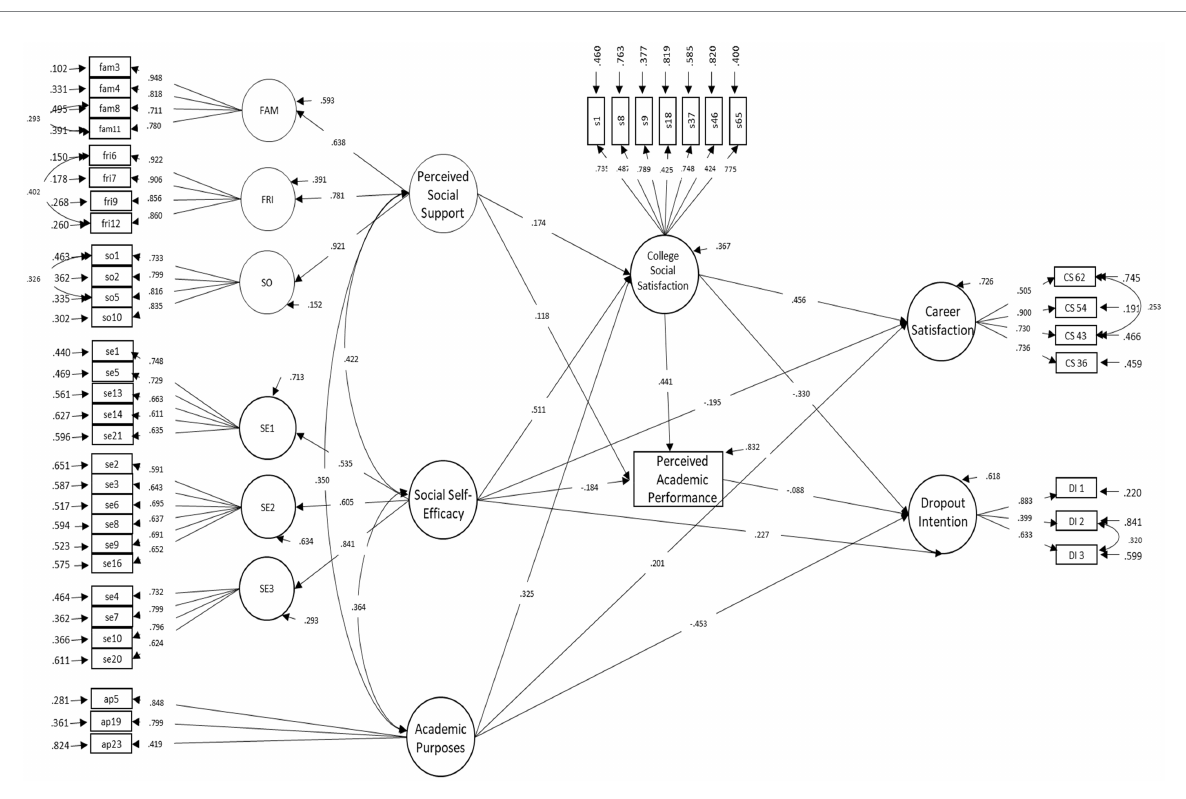
FIGURE 2 Predictive model of the dropout intention of Chilean university